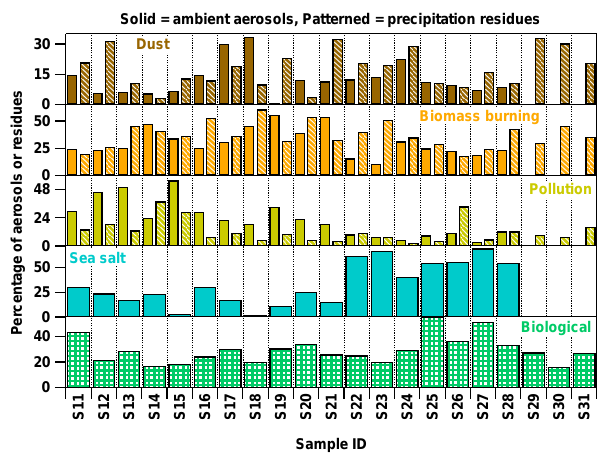
Figure 2. Comparison of average ambient aerosol versus pre- cipitation residue composition per sampling time period during CalWater 2010. Percentages represent either the number of each type of aerosol or residue per total number of aerosols or residues analyzed per sample. Sea salt was not observed in precipitation and biological particles were not observed in the ambient